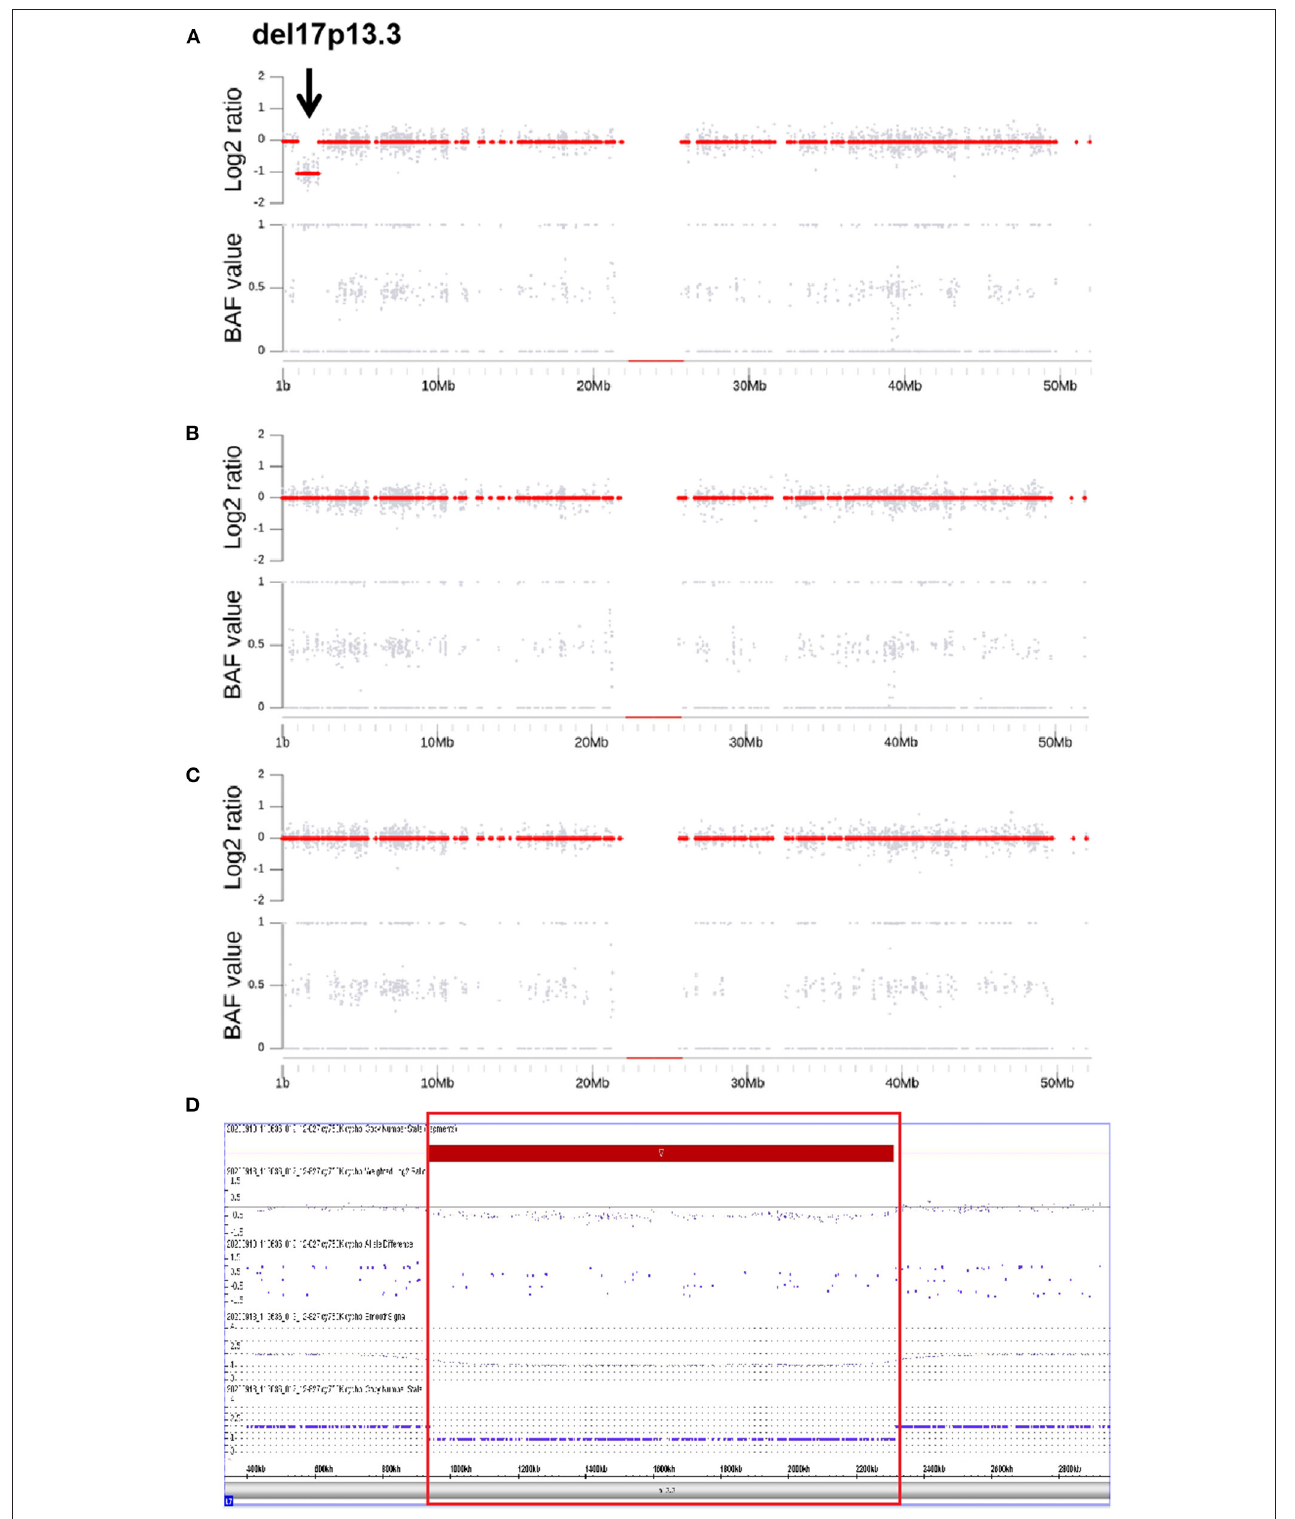
FIGURE 1 | B allele Frequency, Log 2 Ratio plots and CMA of a de novo heterozygous deletion of 17p13.3 in the patient with Miller-Dieker syndrome. In (A–C) , the upper and the lower subplots are the copy number